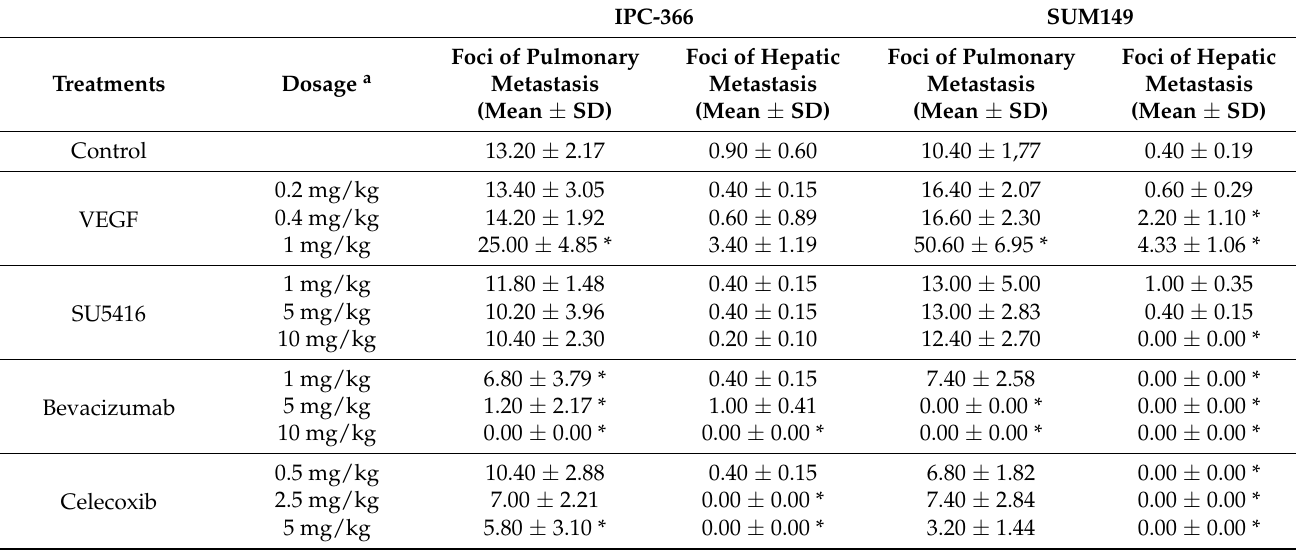
Figure 6. Body weight from xenotransplanted mice. Bar represents means ± SEM. * Significant differences between control and treatment groups ( p < 0.05). Table 2. Foci of pulmonary and hepatic metastasis in control and experimental groups of IPC-366 and